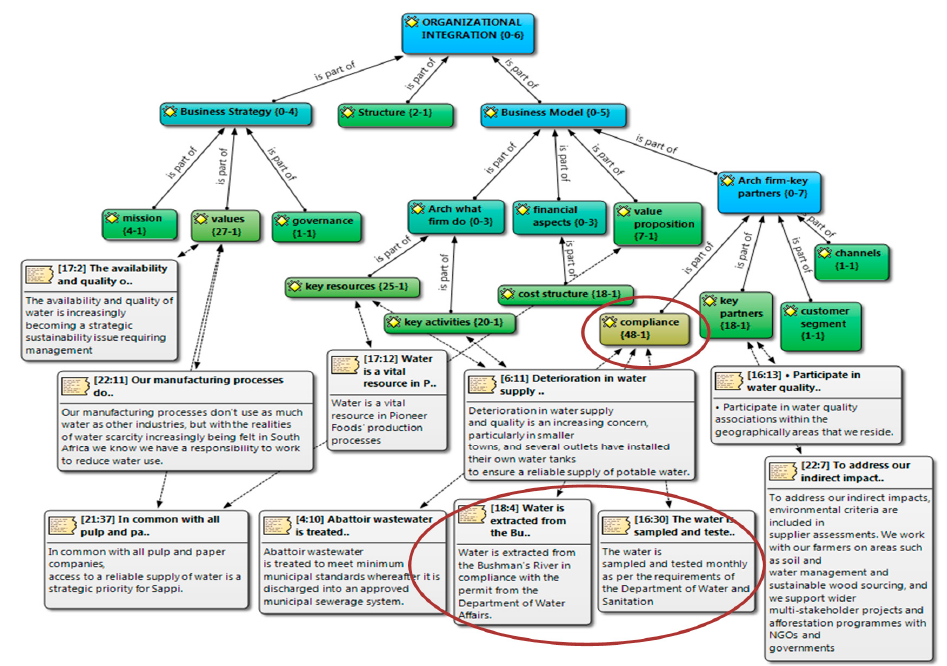
Figure 2. Organizational Integration ( Source: Own work ).